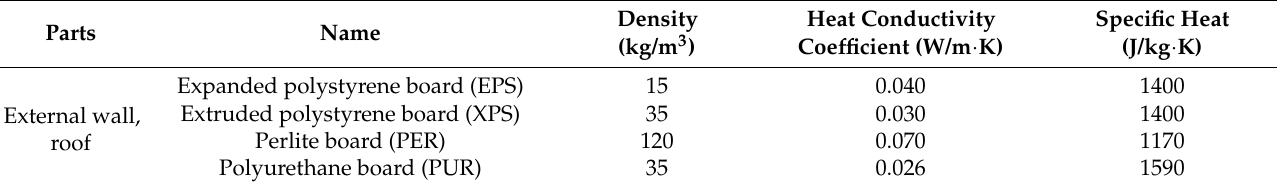
Table 4. Physical properties of insulation materials used in rural housing.